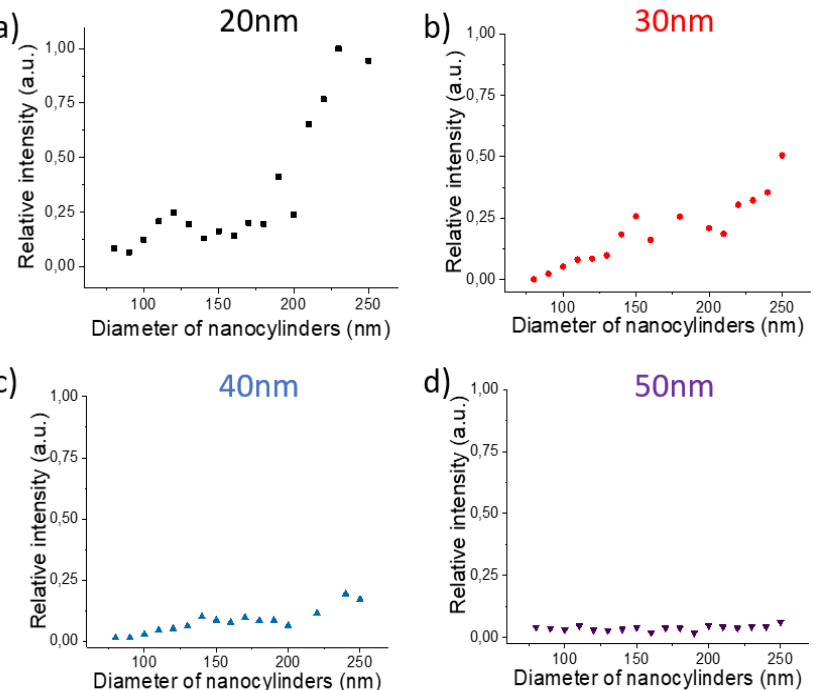
Figure 4. Evolution of the SERS intensities of the band located at 1580 cm −1 depending on the nanocylinder diameter and for the four film thicknesses: ( a ) 20, ( b ) 30, ( c ) 40, and ( d ) 50 nm. Excitation wavelength: 785 nm. Points size includes the error bars.